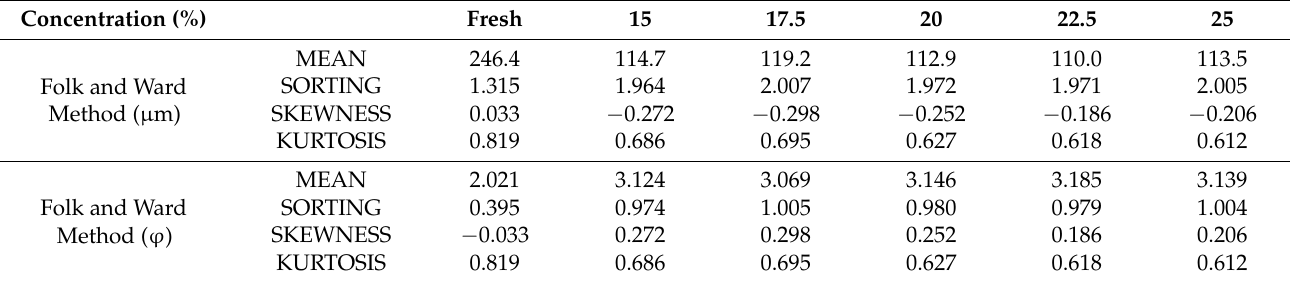
Table 5. Recycled garnet grains distribution